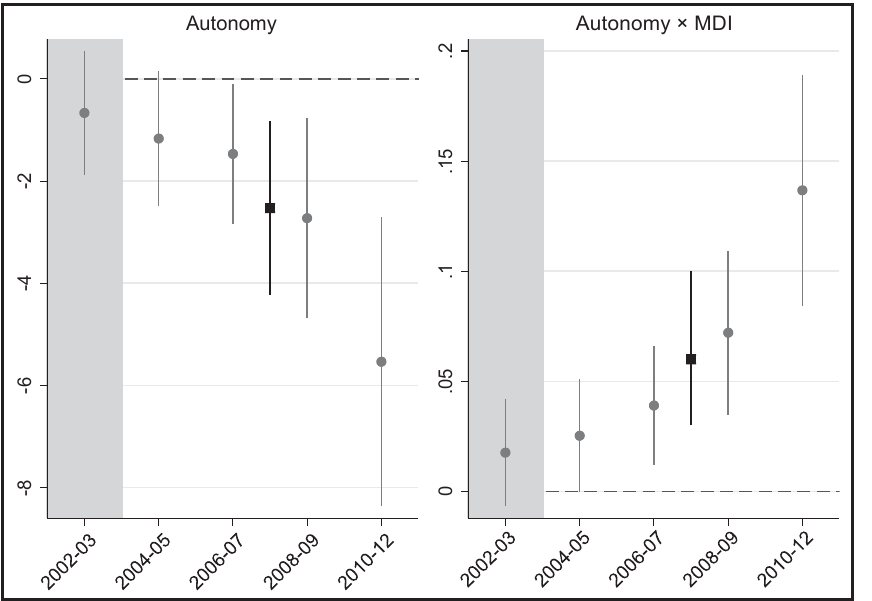
Figure 2 The effect of municipal autonomy on test scores. Notes: The figure plots the coefficients on municipal autonomy (left) and on the interaction between au- tonomy and development (right), estimated at different postreform periods with baseline model (2). Black squares indicate over-time average estimates, and spikes represent 95% confidence intervals. The reform transition period is shaded in